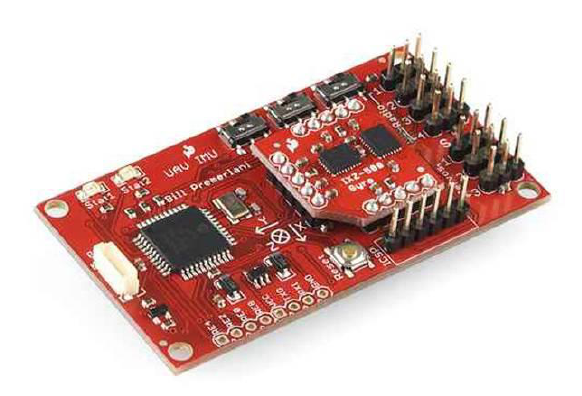
Figure 3. UAV Development Board v3